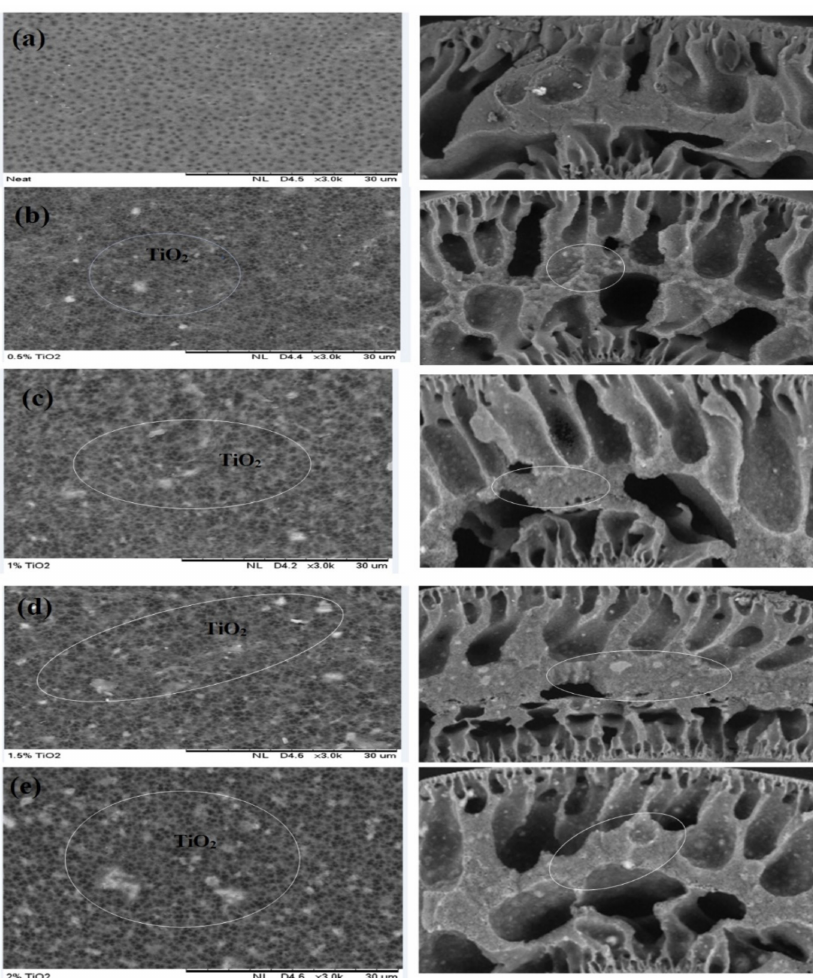
Figure 2. Scanning electron microscopy (SEM) images (cross and outer surface) of membranes fabricated with varying concentrations of TiO 2 : ( a ) neat TiO 2 , ( b ) 0.5 wt% TiO 2 , ( c ) 1.0 wt% TiO 2 , ( d ) 1.5 wt% TiO 2 , and ( e ) 2.0 wt% TiO 2